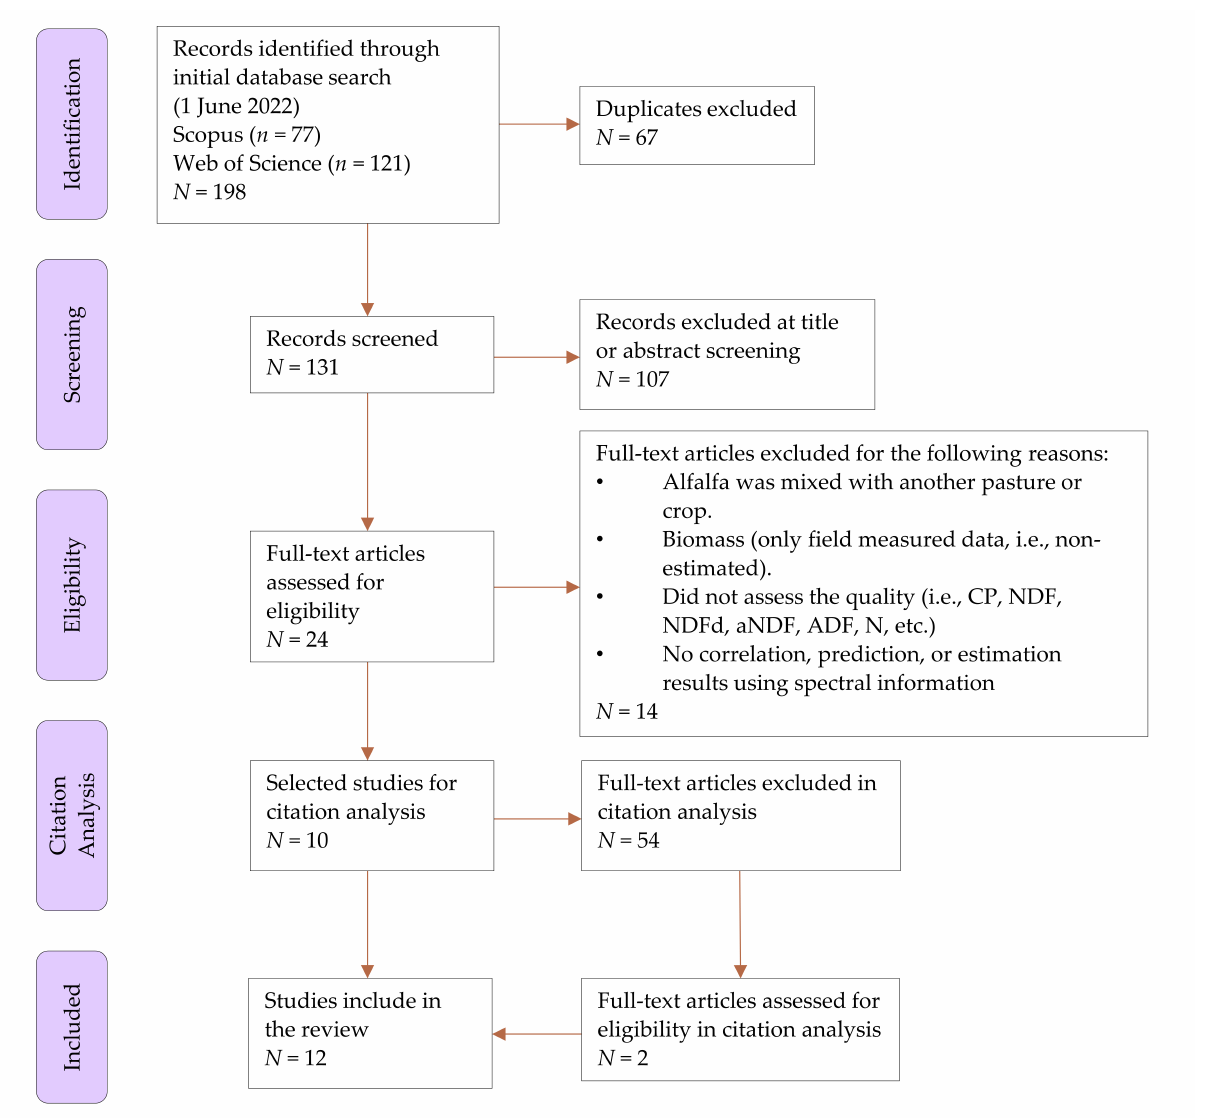
Figure 1. Workflow diagram outlining the systematic review process. The left-hand panels show the five phases of the review, and the center and right-hand boxes show the number of articles for each